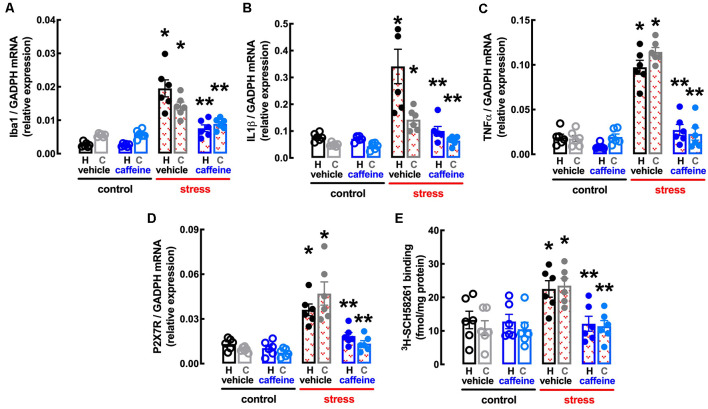
Male adult Wistar rats (8–10 weeks old) subject to a protocol of restraint stress (4 h/day) during 14 days display an increased expression of inflammatory markers and an up-regulation of P2X7 and of A2A receptors in the hippocampus (black, dark blue) and prefrontal cortex (gray, light blue) which were prevented by the adenosine antagonist caffeine (caff). Whereas caffeine consumption (0.3 g/L, po, beginning 3 days before the stress protocol and until the sacrifice of the animals; blue) was devoid of effects in non-stressed control rats (open bars), caffeine prevented all alterations of stressed rats (red checkered bars), namely the increased expression of the microglia marker Iba1 (A), of interleukin 1β (IL1β; B), of tumor necrosis factor α (TNFα; C) and P2X7 receptors (P2X7R; D) as well as an increased density of A2A receptors (A2AR; E) as assessed by the binding density of a supramaximal concentration of the selective A2AR antagonist 3H-SCH58261 (2 nM). Data are shown as mean ± SEM; n = 5–7 rats per group. *P < 0.05 vs. control-water, **P < 0.05 vs. stress-water using a Tukey’s multiple comparisons post hoc test after a two-way ANOVA.